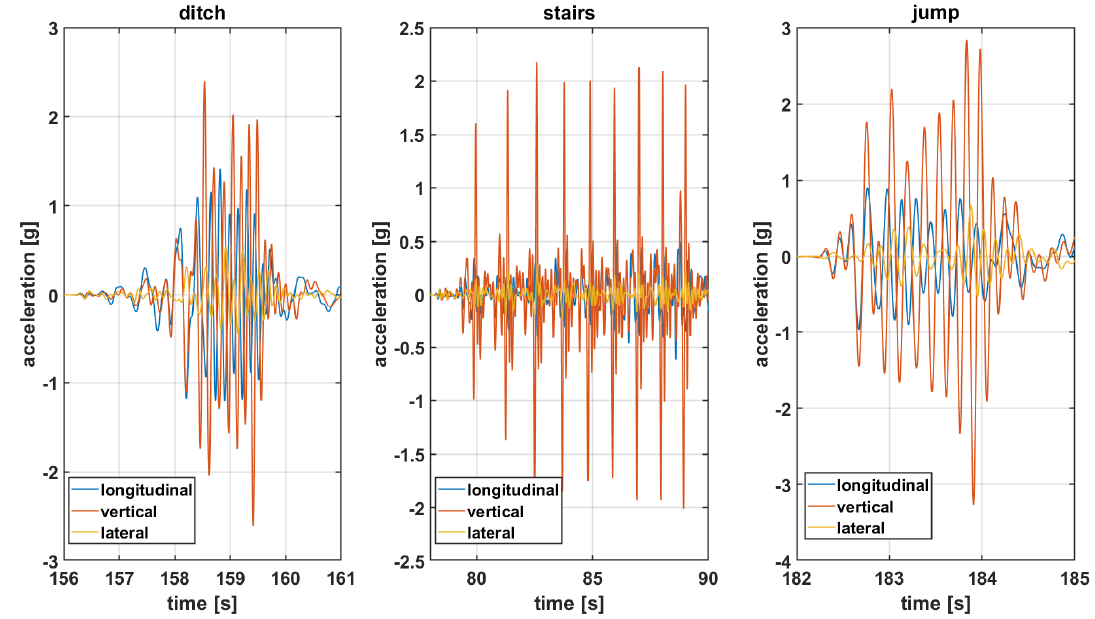
Figure 4. Filtered signals for each obstacle type, from left to right: ditch, stairs and jump.